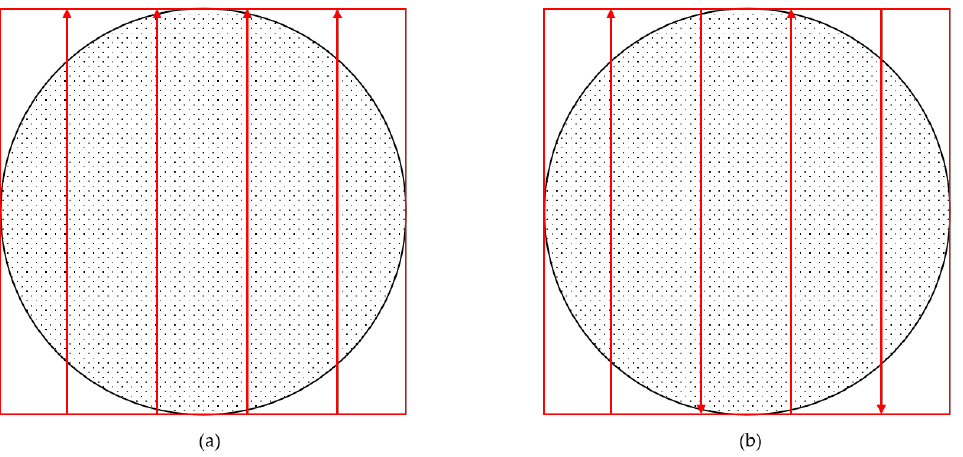
Figure 10. Parallel grinding method for flat workpieces, ( a ) is grinding parallel to one direction, ( b ) is parallel grinding with switched